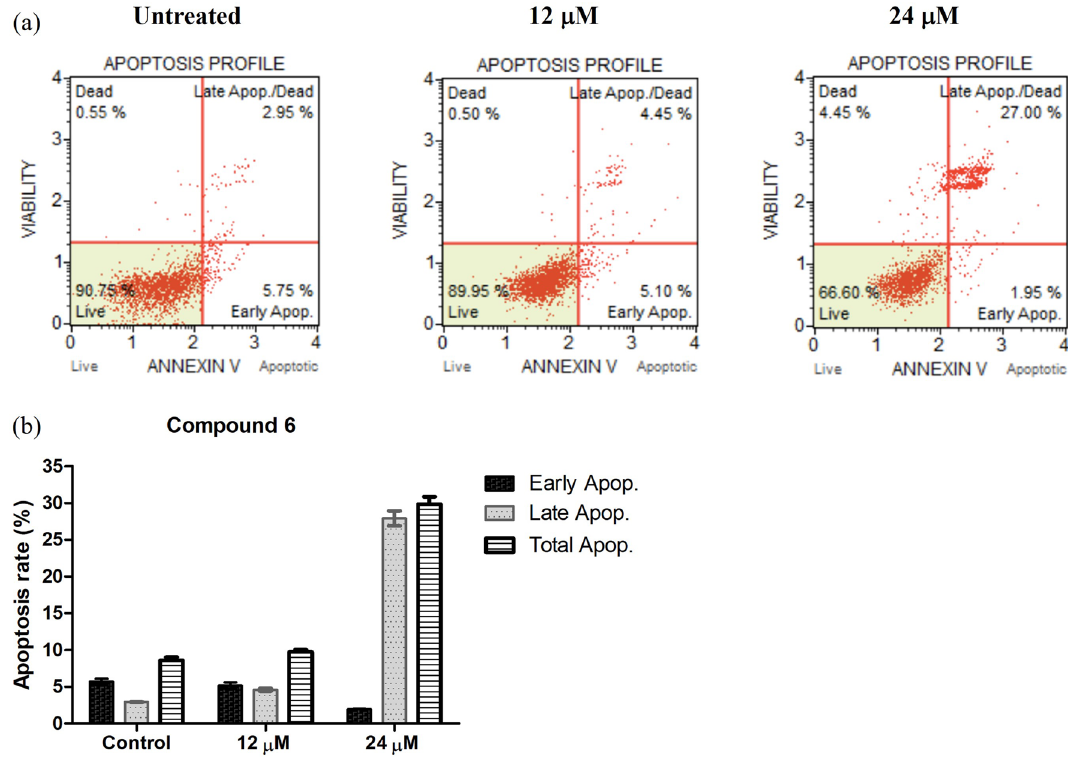
Figure 4. Effect of dulxanthone D ( 6 ) on Huh7 apoptosis .